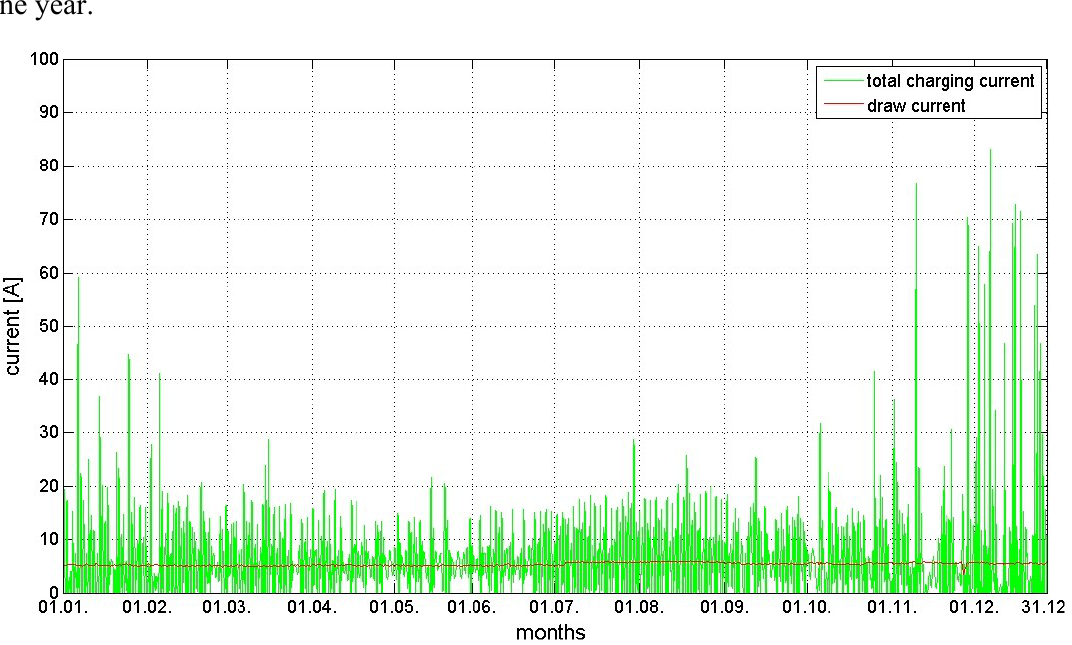
Figure 9. Interdependence of total charging and discharging current for the BSS B during one year.